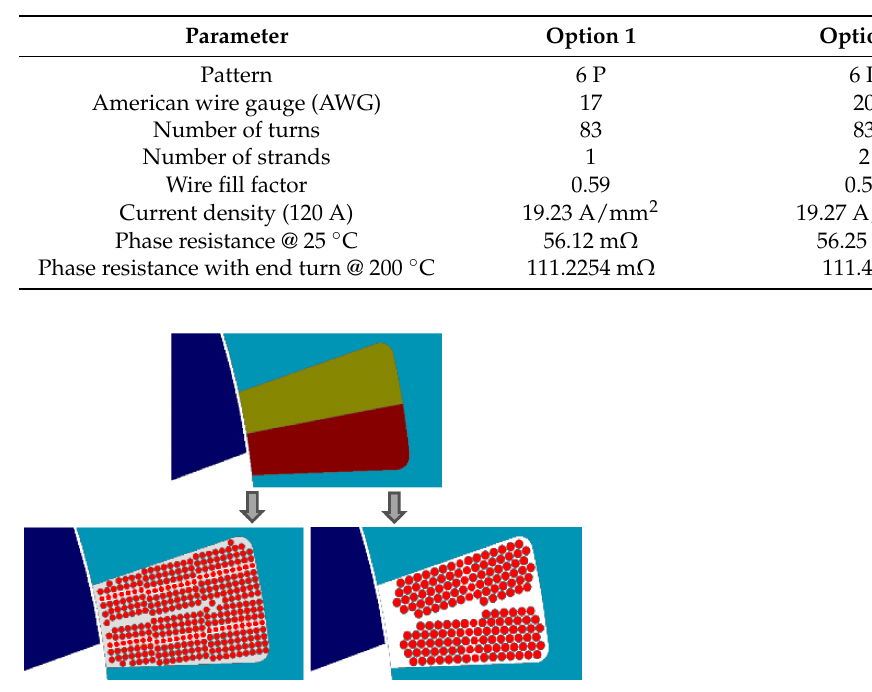
Table 4. Comparison of different coil options.